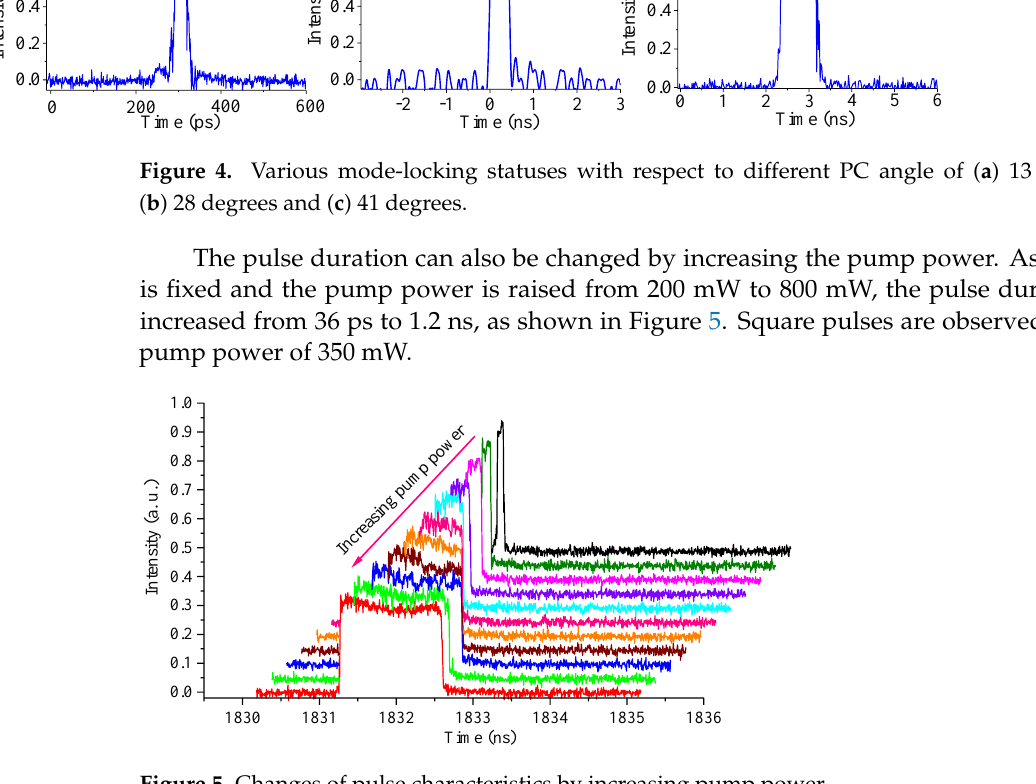
Figure 5. Changes of pulse characteristics by increasing pump power. The average laser power and conversion efficiency as a function of pump power is shown in Figure 6. It is evident that the laser power is linearly raised by increasing the pump power, while the optical – optical conversion efficiency is nonlinearly raised. The maximum laser power is obtained as 42.7 mW under a pump power of 800 mW. The highest conversion efficiency is 5.72%, corresponding to the pump power of 700 mW.